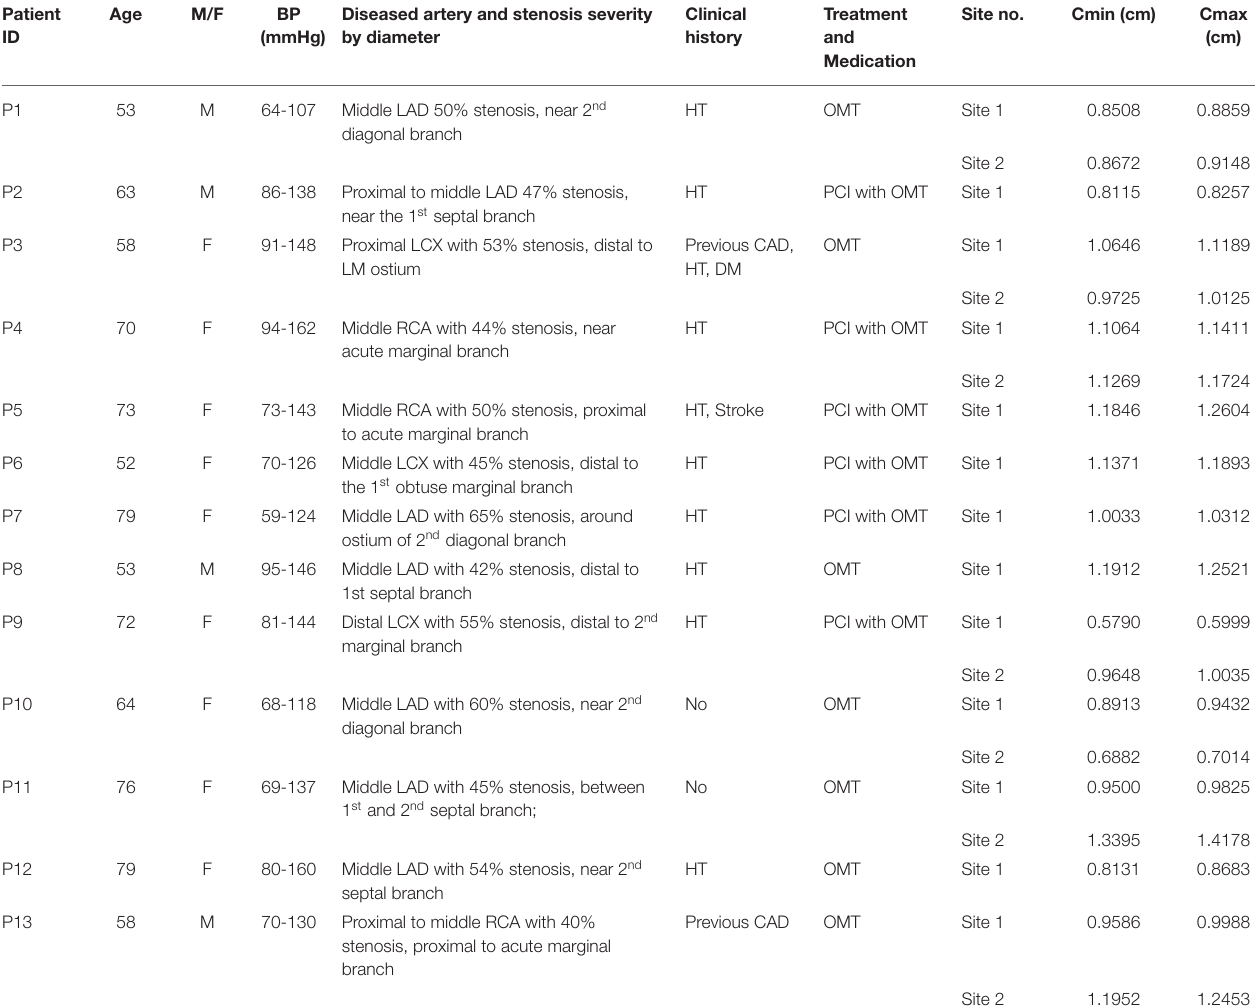
TABLE 1 | Patient demographical and vessel segment information. Patient